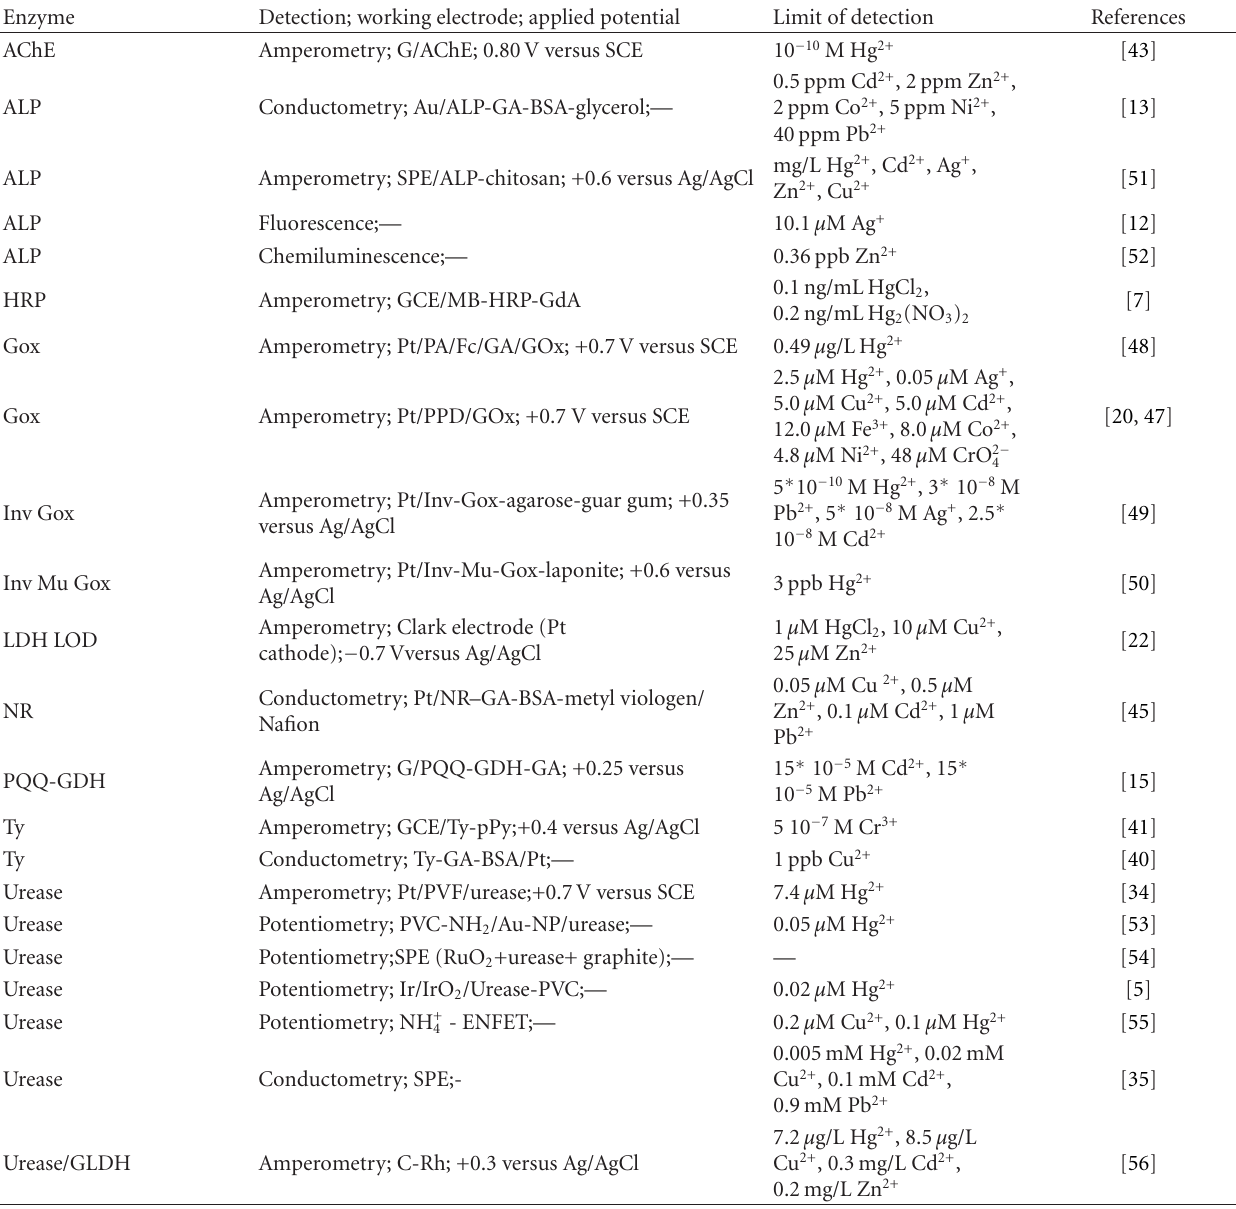
Table 4: Principle characteristics of enzyme biosensors for heavy metal